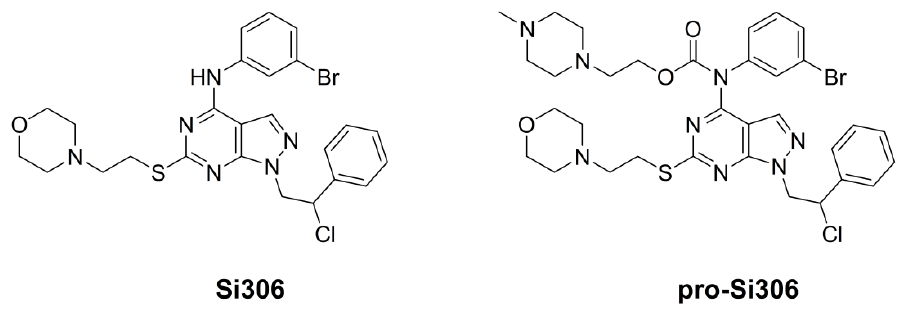
Figure 1. Molecular structure of Si306 and pro-Si306.